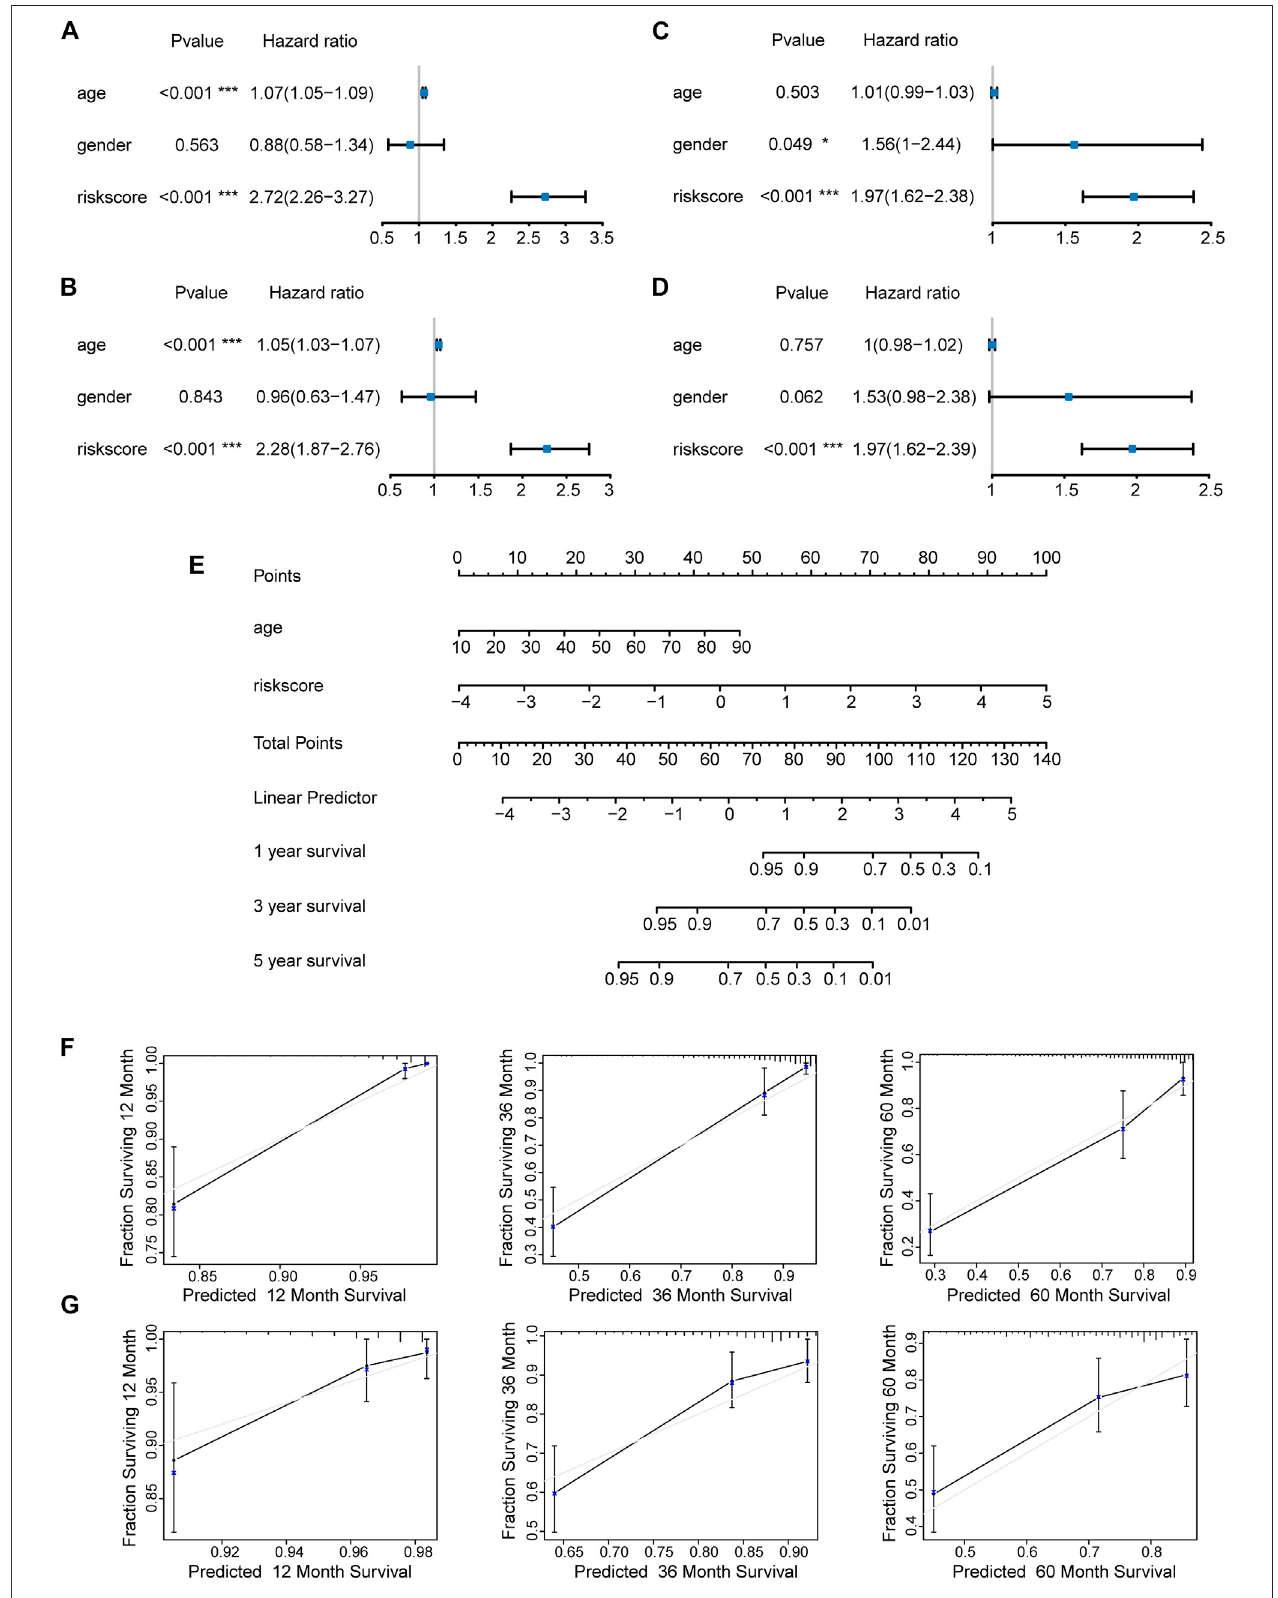
FIGURE 7 | Construction and evaluation of a nomogram. Independent prognostic factors were identi fi ed by univariate and multivariate Cox regression analyses